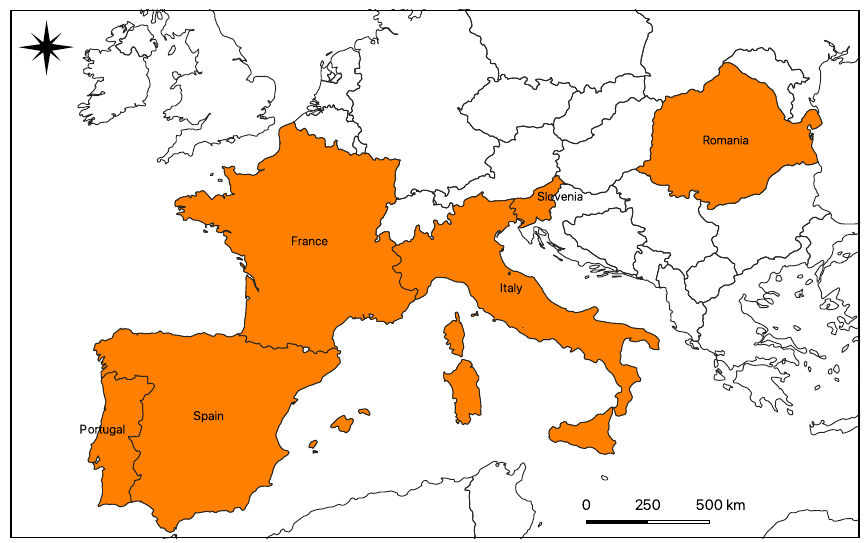
Figure 1. Distribution of A. dealbata in Europe (data collected from [8]).